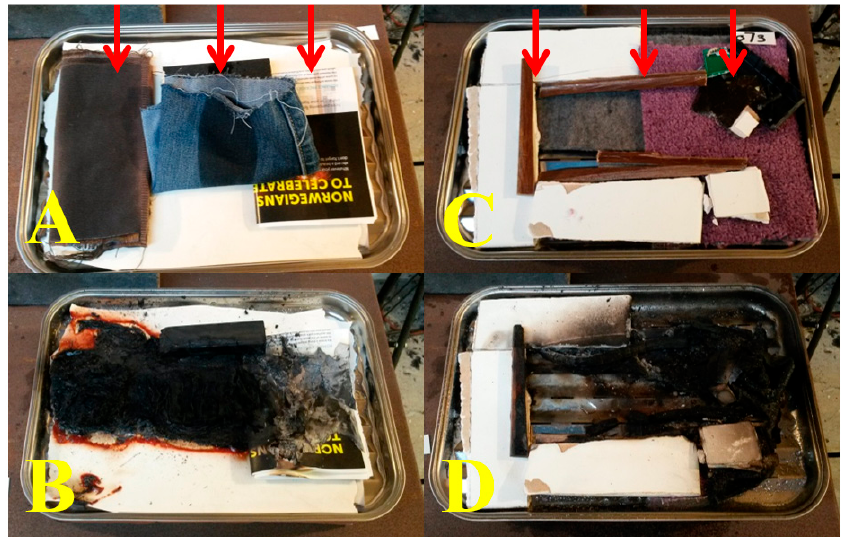
Figure 3. Experimental setup of small scale fires. ( A , C ) show intact substrates to which 15 mL of white spirit has been applied in three vertical lines (indicated with red arrows) and ( B , D ) are the corresponding fire debris samples. Substrates for ( A , B ): vinyl flooring (primary substrate, 60 wt %), plus curtain, wooden chair, magazine, and clothing (secondary substrates, 10 wt % each); substrates for ( C , D ): plasterboard (60 wt %), carpet material, carpet underlay, floor skirting, and computer fragments (monitor, print boards, and cables) (10 wt % each).